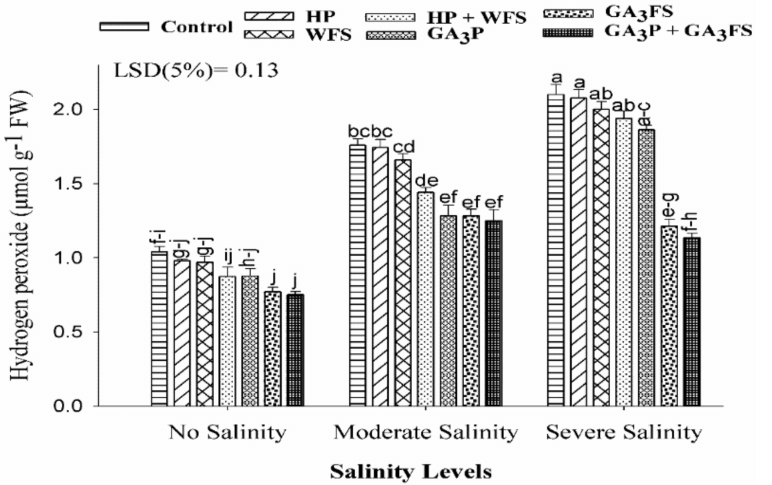
Figure 4. Hydrogen peroxide (H 2 O 2 ) content in maize leaves as affected by different treatments of gibberellic acid under no salinity, moderate salinity (6 dS m − 1 ), and severe salinity (12 dS m − 1 ). Values are means ± SD (n = 3). Hydropriming (HP); water foliar spray (WFS); hydropriming and water foliar spray (HP + WFS); seed priming with GA 3 (GA 3 P); foliar spray with GA 3 (GA 3 FS); seed priming and foliar spray of GA 3 (GA 3 P + GA 3 FS). Bars with the same letters do not differ significantly at p ≤